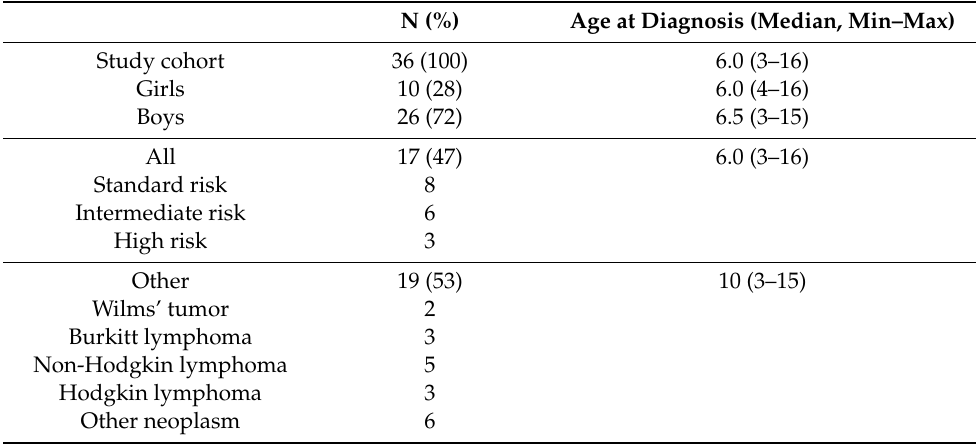
Table 1. The demographics of the study participants.